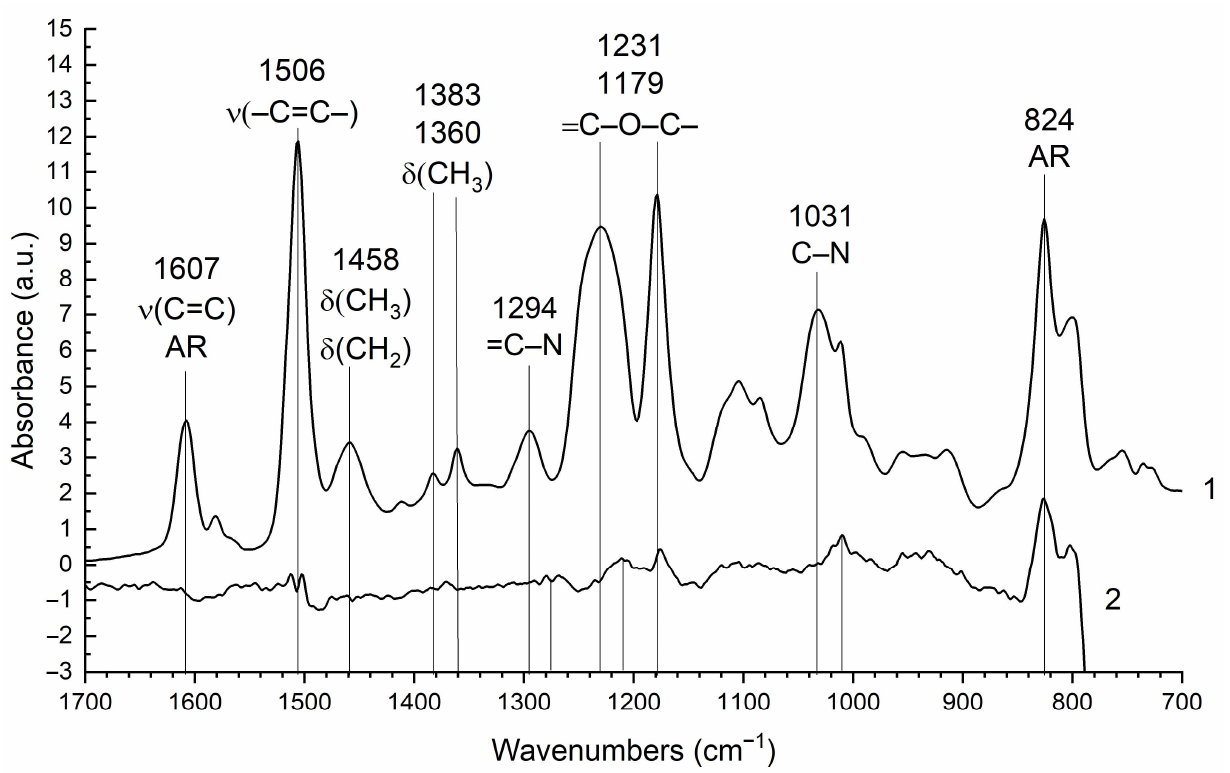
Figure 7. IR spectrum of cured ED-20 (1); difference spectrum obtained as a result of subtraction of the spectrum of the TiO 2 /EP nanocomposite (3 wt. % TiO 2 d av = 46 nm) from the spectrum of the cured ED-20 (2).